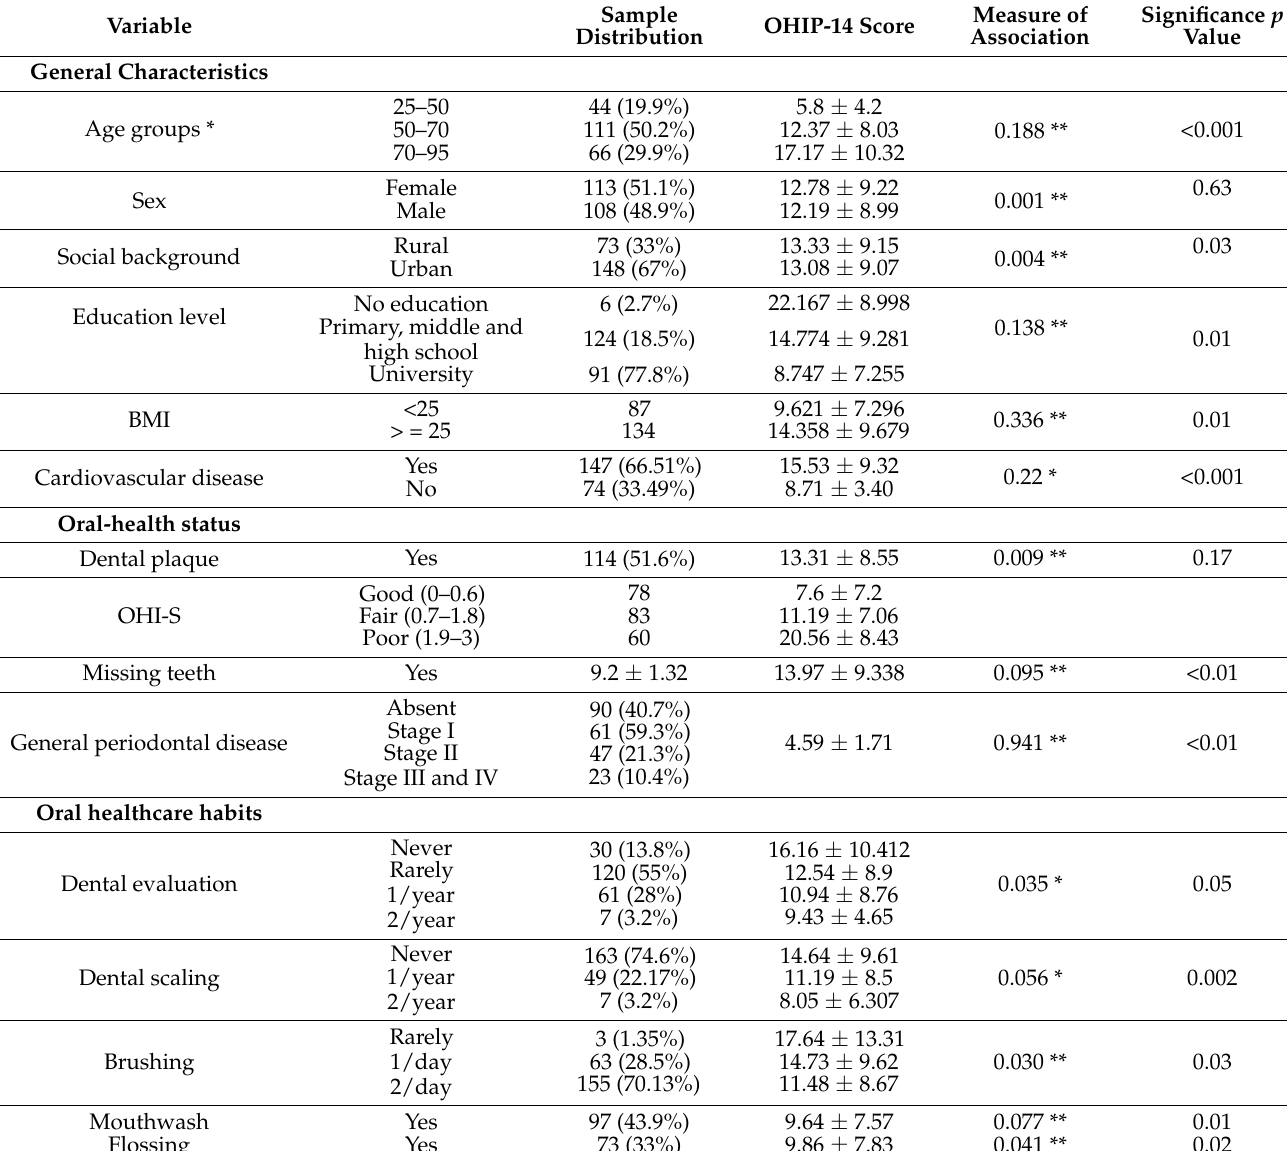
Table 1. Population characteristics and OHIP-14 general score.